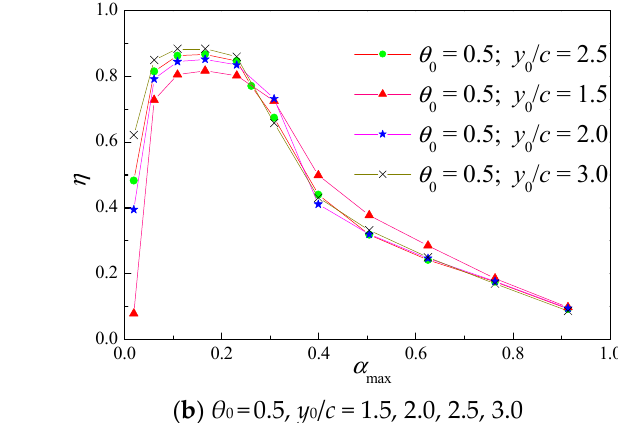
Figure 13. Propulsive efficiency η as function of advance coefficient J , for different heaving amplitude and pitching am- plitude.